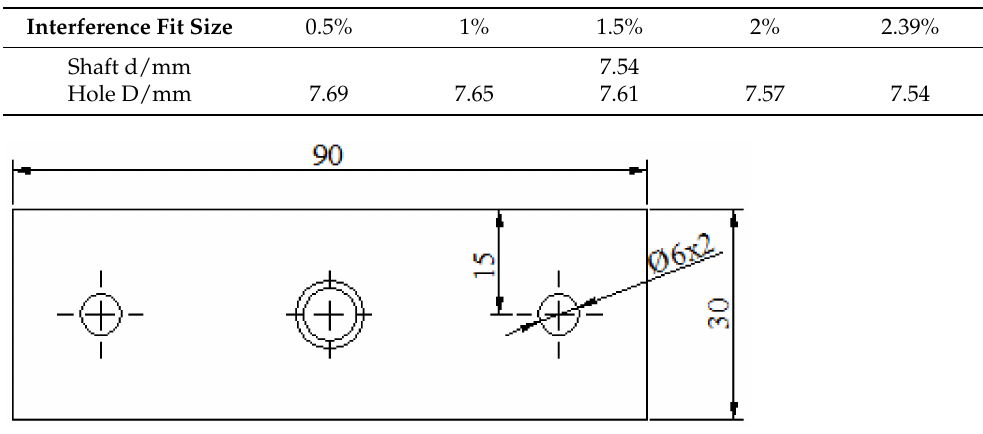
Figure 7. Geometric dimensions of the connection plate.